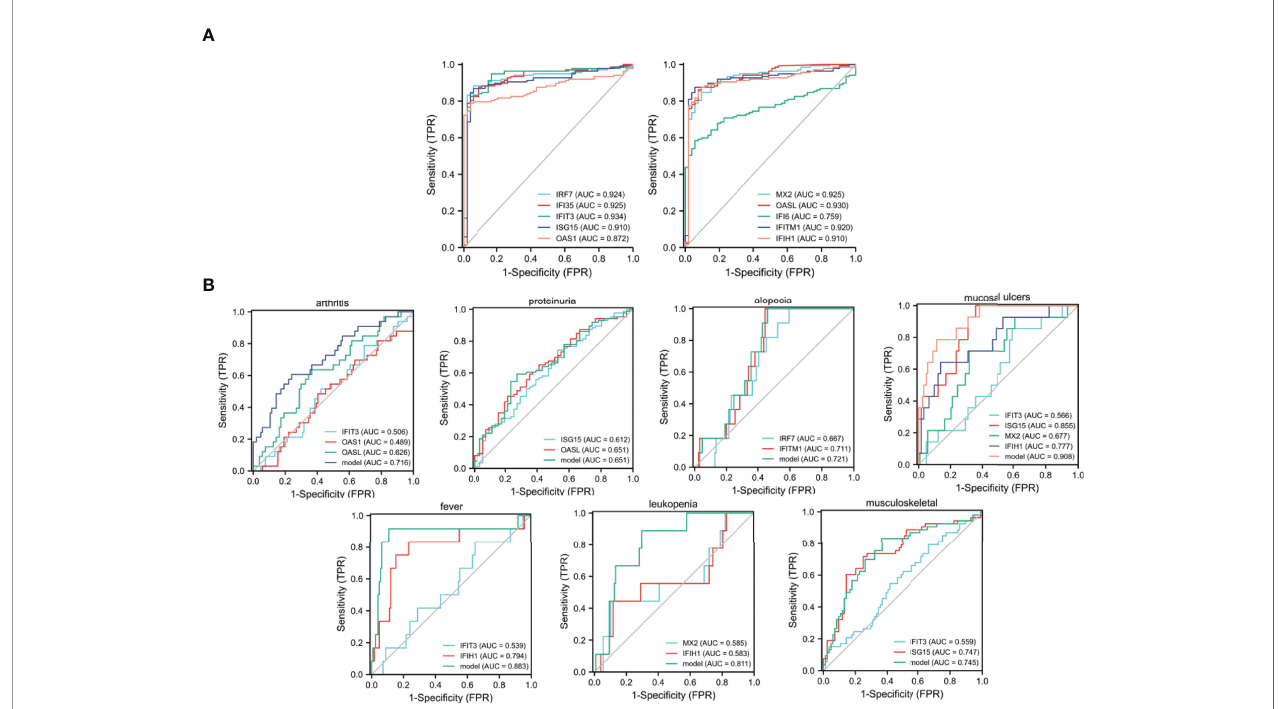
FIGURE 3 | ROC curves generating by GSE65391. (A) ROC curves of the 10 identi fi ed hub genes in diagnosing SLE, (B) ROC curves of the identi fi ed hub genes in detecting different clinical manifestations of